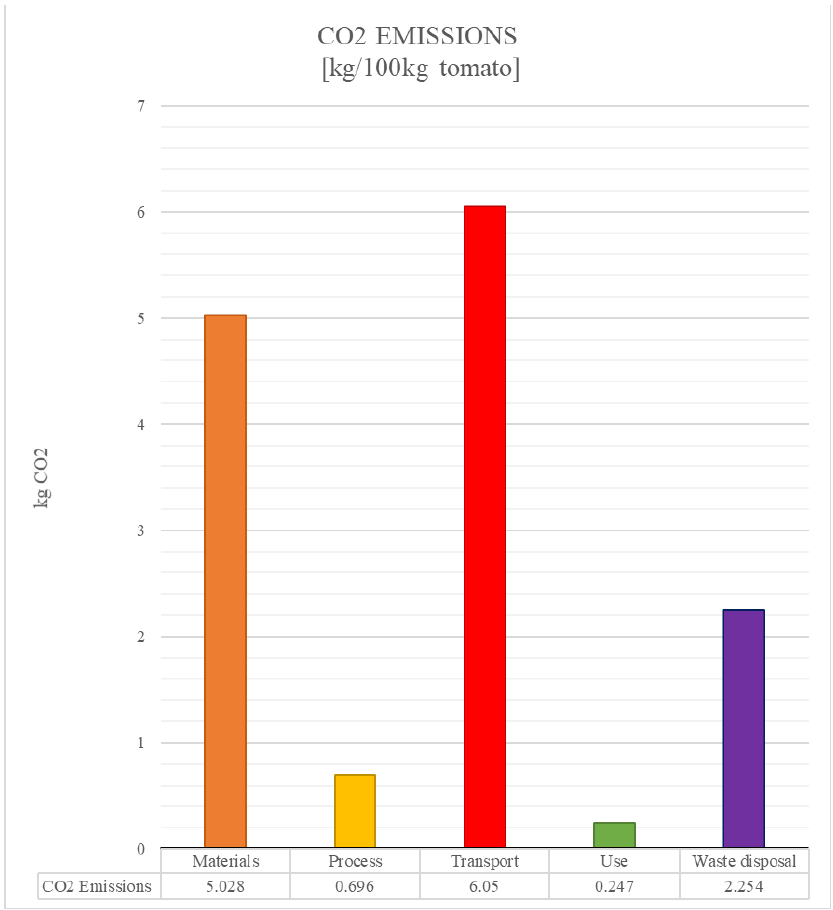
Figure 3. CO 2 emissions of 100 kg of greenhouse tomatoes per life cycle stage (in kg).